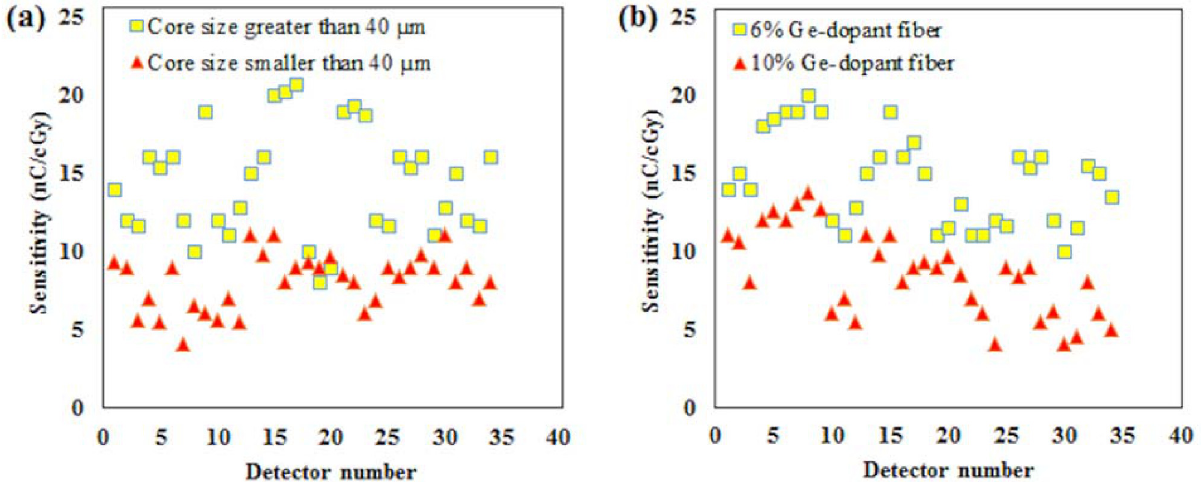
Fig 7. TL sensitivity for different core size and Ge concentration detectors. TL sensitivity of detectors with respect to: (a) Core diameter and; (b) Ge concentration.